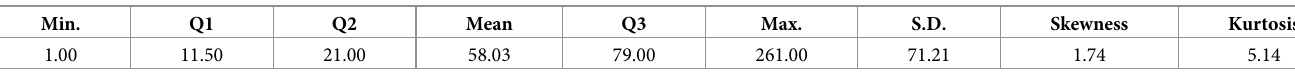
Table 2. Descriptive statistics of failure times of 31 air conditioners of airplane. Min.